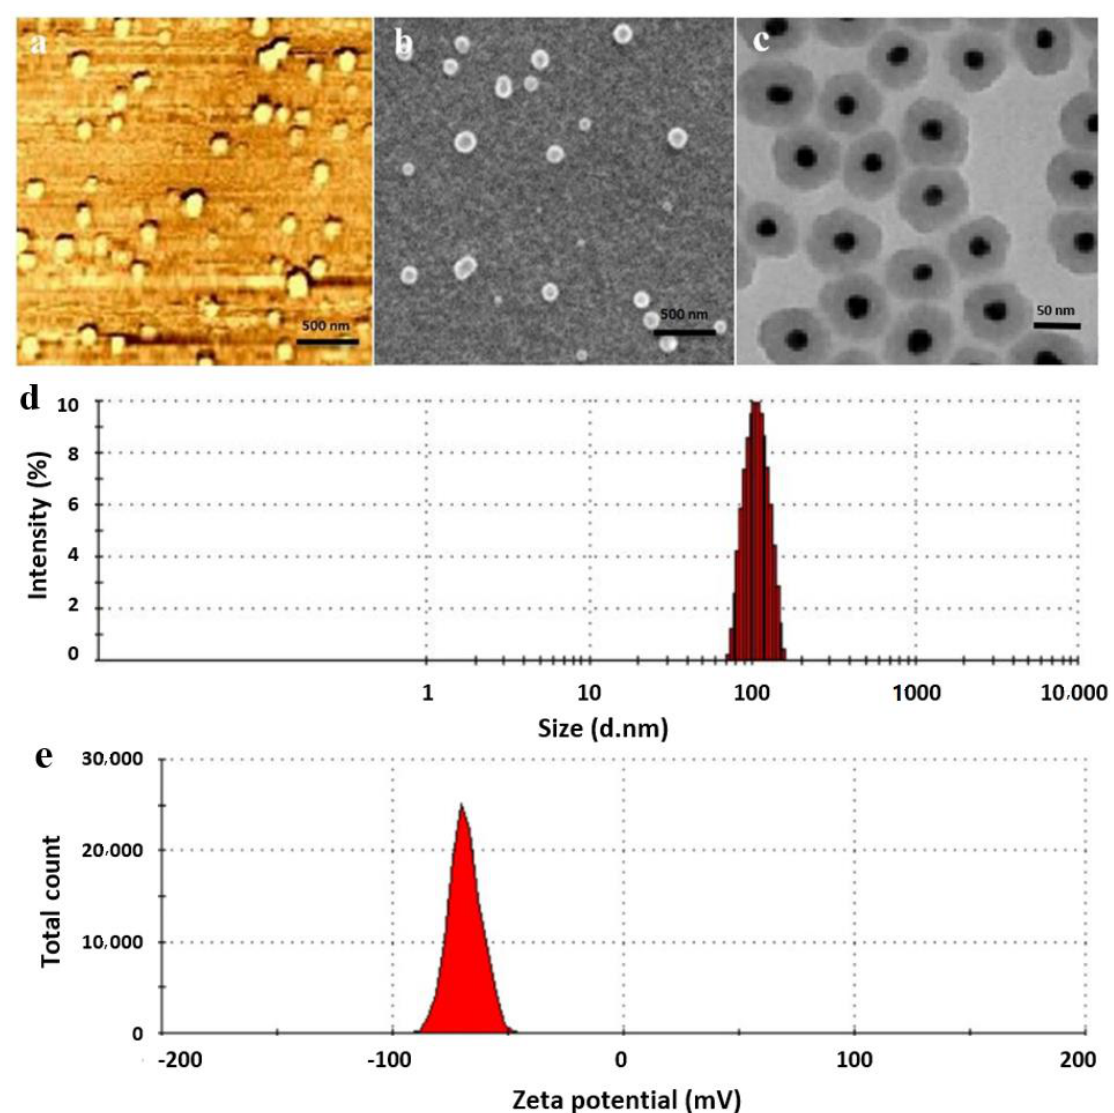
Figure 1. Characterization of the designed (SPION@Au-CS-FA nanocomposite) with different techniques. ( a ) atomic force microscope (AFM), ( b ) scanning electron microscope (SEM), ( c ) transmission electron microscope (TEM) images, ( d ) the particle size distribution of SPION@Au-CS-FA and ( e ) charge measurement uses dynamic light scattering (DLS). Abbre-